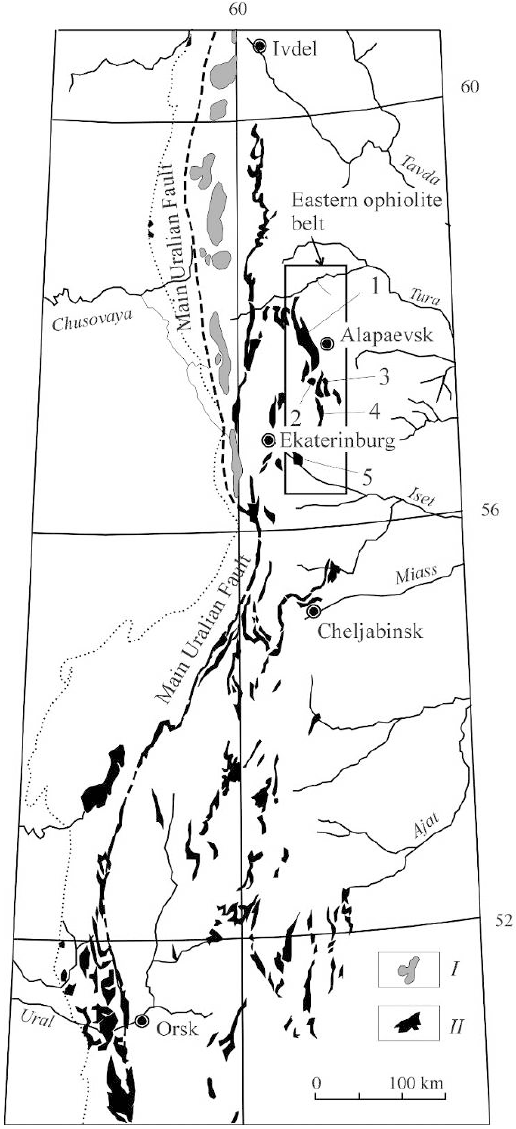
Figure 1. The distribution of mafic–ultramafic complexes in the Urals (excluding Circumpolar and Polar sectors of the Urals) (simplified after [2]). I—dunite-clinopyroxenite-gabbro massifs of the Ural Platinum Belt; II—ophiolite complexes. Eastern ophiolite belt: 1—Alapaevsk massif; 2—Ostaninsky massif; 3—Rezhevskoy massif; 4—Bazhenovsky massif; 5—Kluchevskoy massif. Rectangle shows the northern end of the Eastern ophiolite belt where the Alapaevsk massif is located.